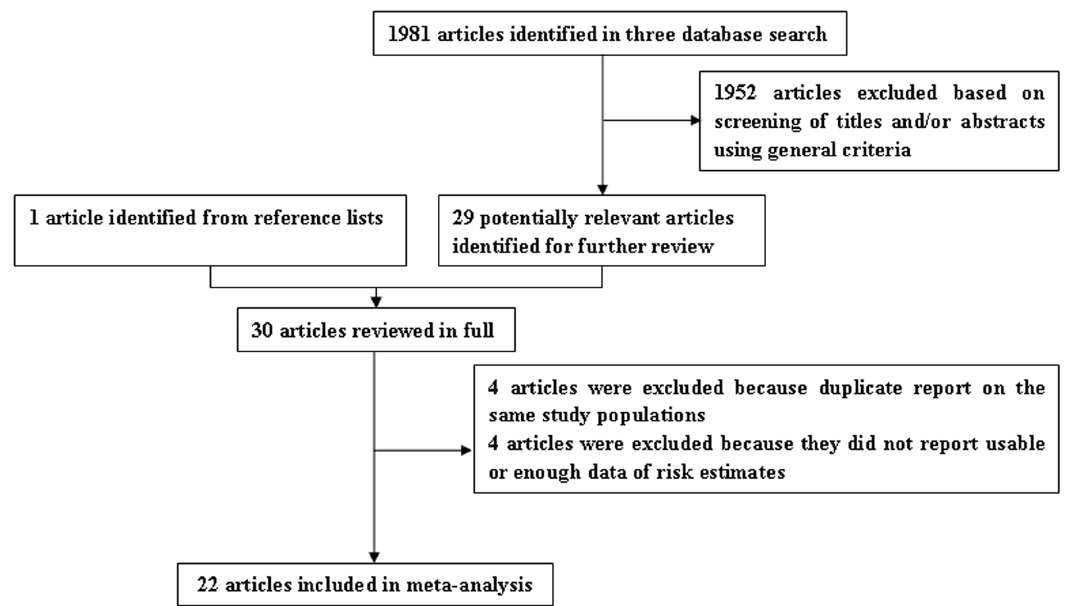
Figure 1. Selection of studies for inclusion in meta-analysis.